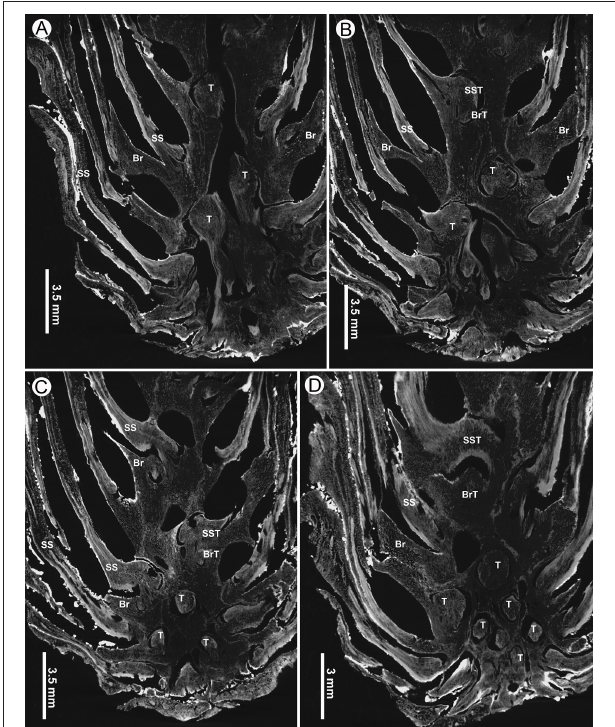
FIGURE 9 | Virtual tangential sections near base of a seed cone of Pinus prehwangshanensis sp. nov., holotype, specimen MMRH170, micro-CT. (A – D) Circular traces (T) of bract-scale vascular complexes diverging from the axial vascular cylinder and supplying seed scales (SS) and bracts (Br); note the traces of vascular bundles to seed scales (SST) and bracts